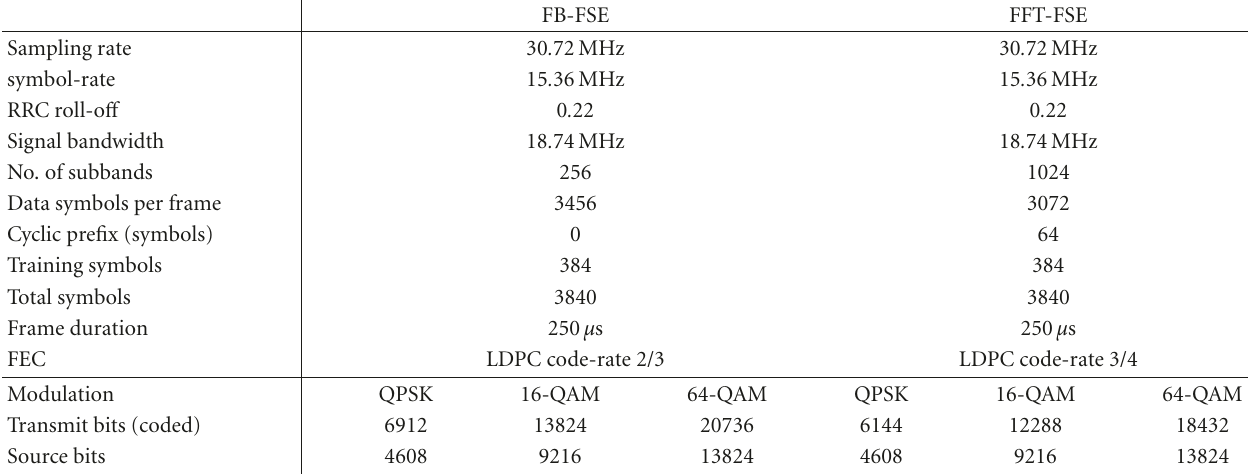
Table 1: FFT-FDE and FB-FDE system parameters.